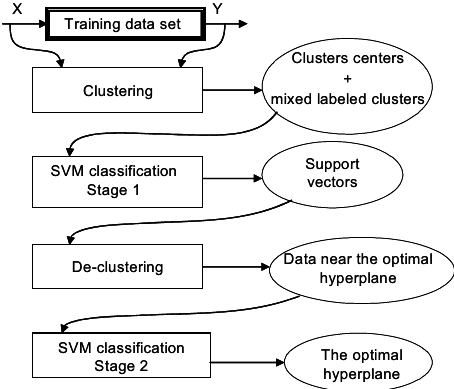
Figure 1. Two-stage SVM